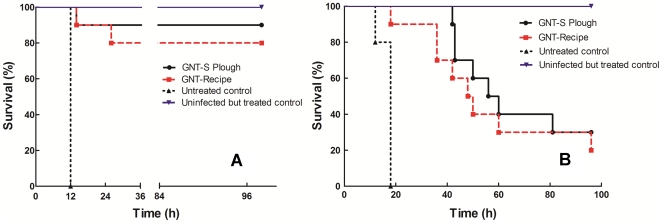
Results from survival experiments.Log-rank test curves obtained from neutropenic mice infected in the thighs with P. aeruginosa GRP-0019 and treated during 4 days with placebo (n = 5), GNT-Recipe (n = 10), or the innovator of gentamicin (n = 10) at the dose required for maximal effect (768 mg/kg per day divided q6h), starting 2 h (panel A) or 6 h (panel B) post-infection. Uninfected neutropenic mice serving as toxicity controls received the same treatment and were identical to the other animals but, instead of P. aeruginosa, were mock-inoculated in the thighs with sterile saline (n = 5 mice per gentamicin product). No significant impact on survival was detected between both gentamicin products.